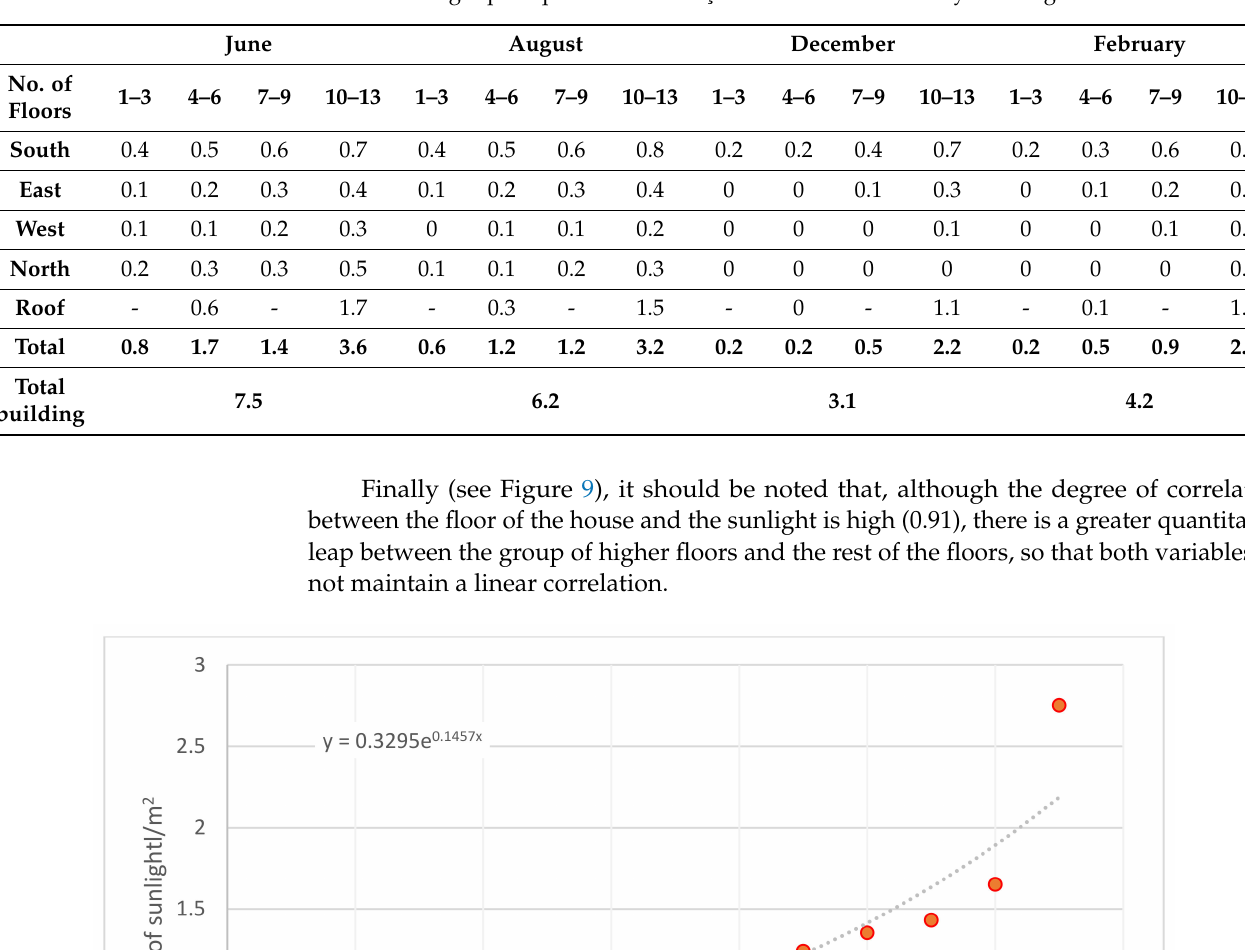
Table 3. Hours of direct sunlight per square meter of façade surface. Multi-family building case.